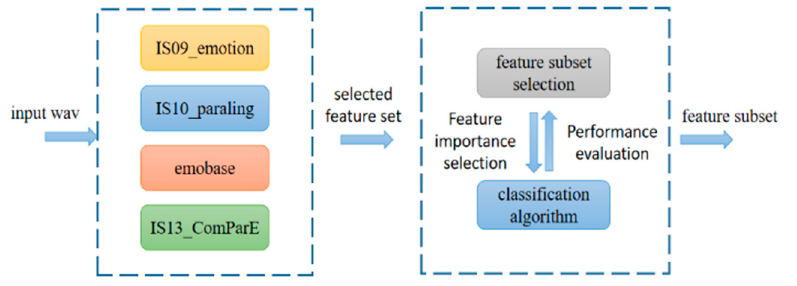
Figure 3. Emotion recognition model MHA-CRNN framework. Contains three large convolutional pooling blocks, two dropout layers, a multi-head attention layer, a Bi-LSTM, and a fully connected layer.